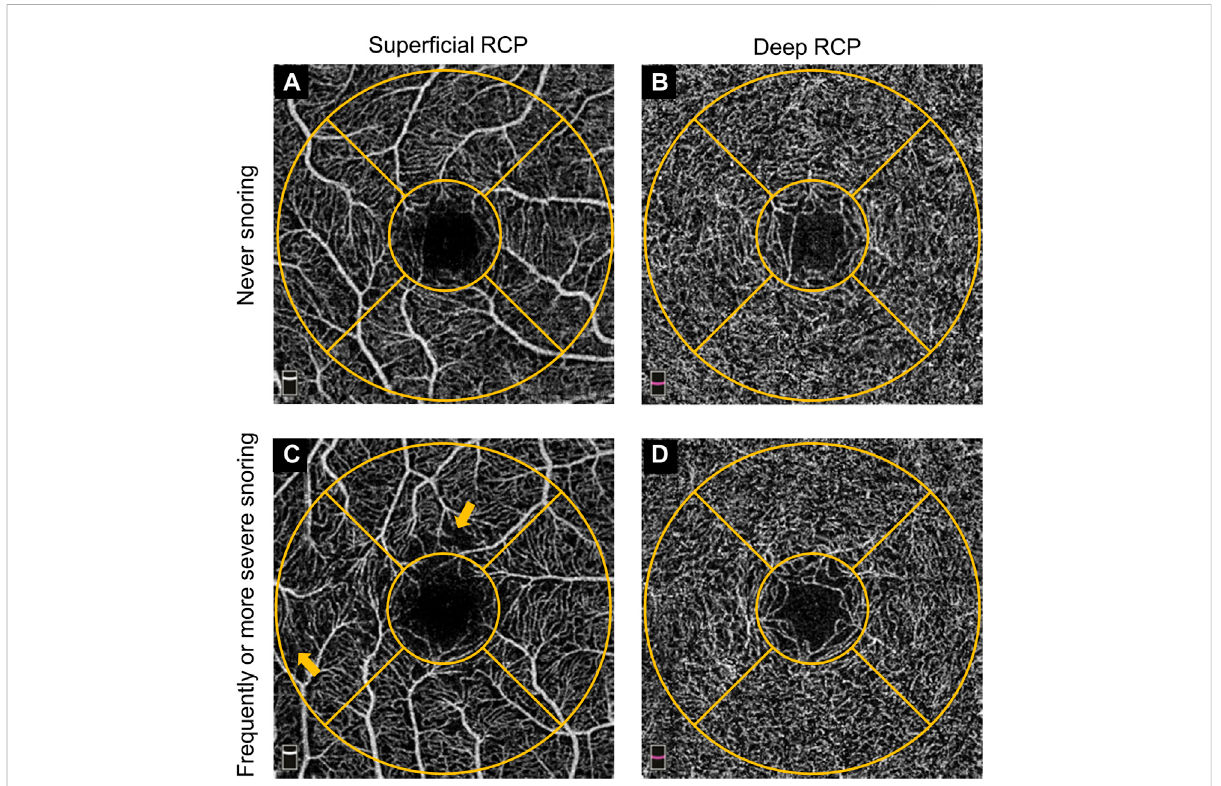
FIGURE 1 RepresentativeOCTAimagesofself-reportedneversnoringandfrequentlyormoreseveresnoringparticipants. (A) .Super fi cialRCPimagefrom a never snoring participant. (B) . Deep RCP image from a never snoring participant. (C) . Super fi cial RCP image from a frequently or more severe snoring participant. (D) . Deep RCP image from a frequently or more severe snoring participant. The orange-colored concentric circle